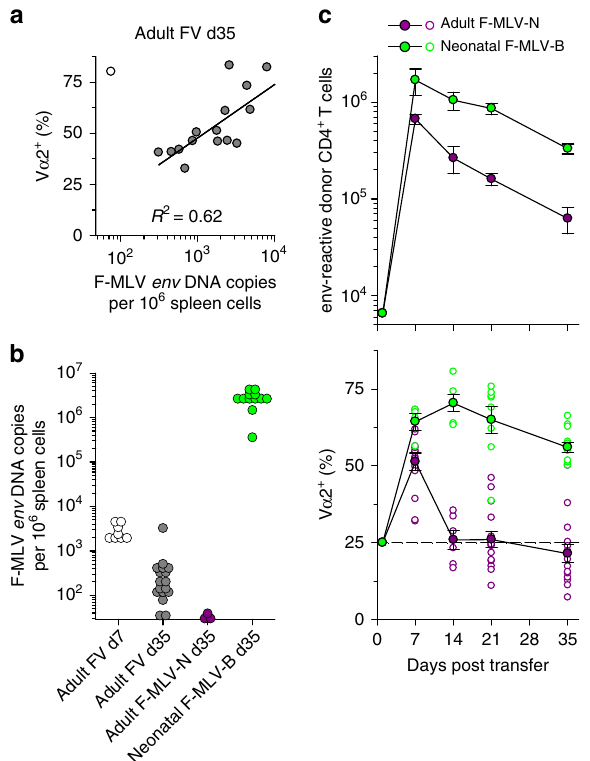
Figure 3 | Effect of infection kinetics on the clonal composition of virus- specific CD4 þ T cells. ( a ) Frequency of V a 2 þ cells within env-reactive donor EF4. 1 CD4 þ Tcells plotted against copies of F-MLV env DNA in the spleens of recipient mice 35 days after adoptive T-cell transfer and FV infection. Symbols represent individual mice. The mouse represented with an open symbol was excluded from the regression analysis. ( b ) Copies of F-MLV env DNA in the spleens of recipient mice that were infected as adults with FV or F-MLV-N or as neonates with F-MLV-B. All recipients received EF4.1 CD4 þ T cells as adults and analysed at the indicated time point after T-cell transfer. Each symbol is an individual mouse. The dashed line denotes the detection limit. ( c ) Absolute numbers (top) and V a composition (bottom) of env-reactive donor EF4.1 CD4 þ T cells in the spleens of recipient mice after T-cell adoptive transfer in adult mice either infected with F-MLV-N at the time of T-cell transfer or with F-MLV-B as neonates ( n ¼ 4–15 mice per time point; P o 0.001 between the two types of host on days 14–35, Mann–Whitney rank sum test). Closed symbols are the means ( ± s.e.m.); open symbols are individual mice; the dashed line represents the frequency of V a 2 þ cells in preimmune env-reactive EF4.1 CD4 þ T